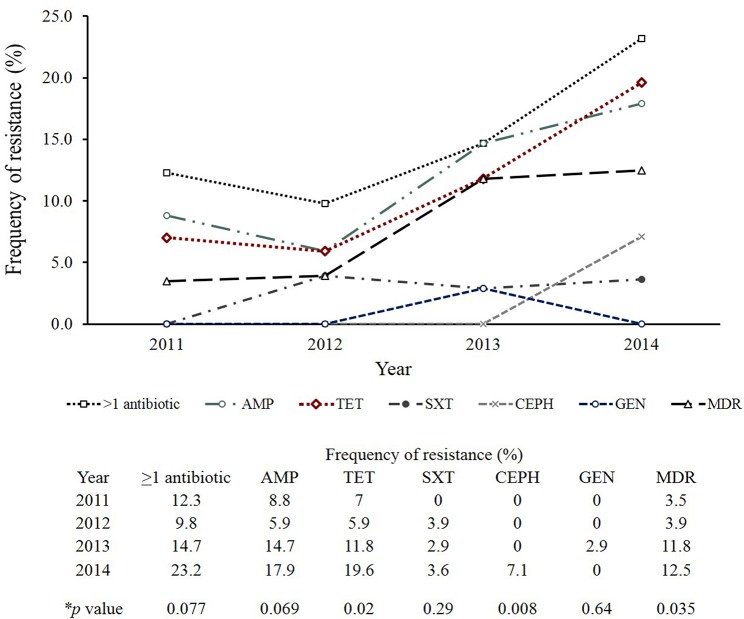
Trends in antibiotic resistance among clinical non-typhoidal Salmonella (NTS) isolates from Michigan over time. Mantel-Haenszel chi-square was used to identify trends over time and calculate p-values. AMP, Ampicillin; TET, Tetracycline; SXT, Trimethoprim/sulfamethoxazole; CEPH, Cephalosporin; GEN, Gentamicin; MDR, Multidrug resistance (resistance to ≥3 antimicrobial classes).